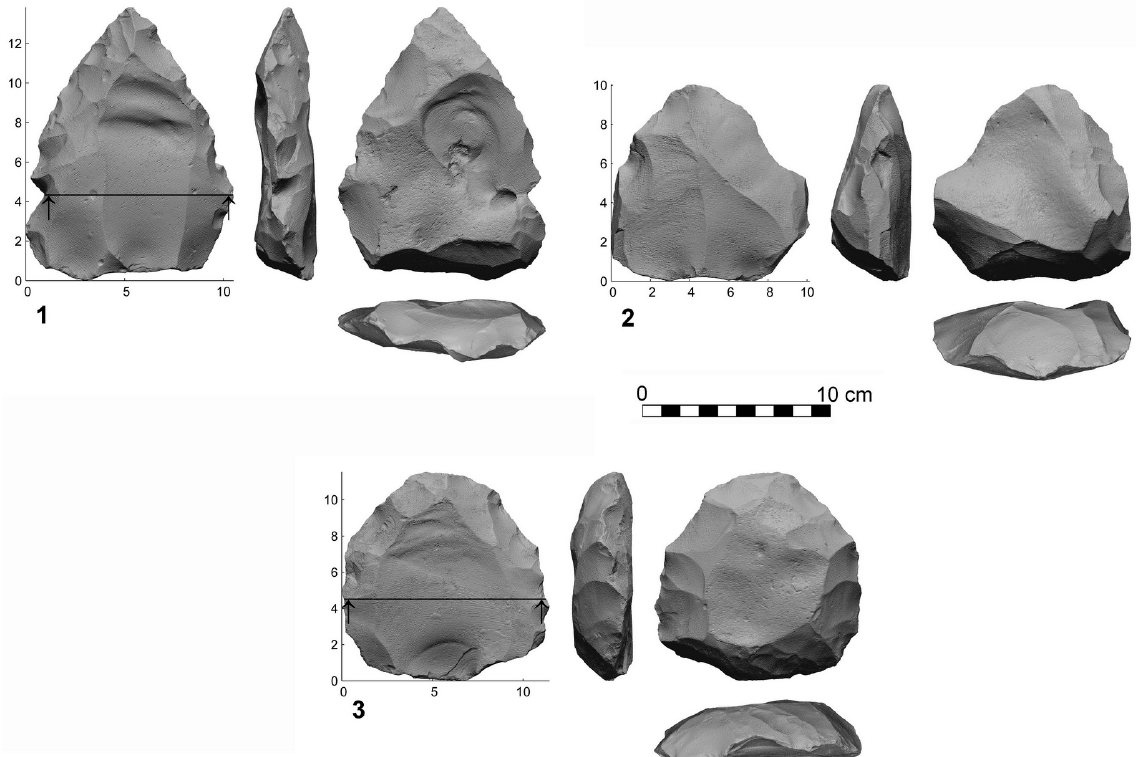
Figure 8. 3D scans of artifacts from Nahal Paran 9 - 1, Nubian core (346_3), 2, Levallois bidirectional preferential core (346_6), 3, Levallois centripetal preferential (346_2). For Nahal Paran 9 only core distribution was recorded and when compared to other sites it is relatively low. The average core density at Nahal Paran 9 is 0.37 cores per m 2 , while at Har Oded, the average density is 2 cores per m 2 (Boutié & Rosen 1989). In the Al Jawf region, Arabia, artifact densities amounted to 1-4 artifacts per m 2 (Hilbert et al. 2017), while the surveyed localities on the Abydos plateau, Egypt have an average density of 3.49 artifacts per m 2 , with the maximum density reported for a single locality of 144.83 artifacts per m 2 . Localities with the highest artifact densities appear on the ridges adjacent to the central wadi system (Olszewski et al.